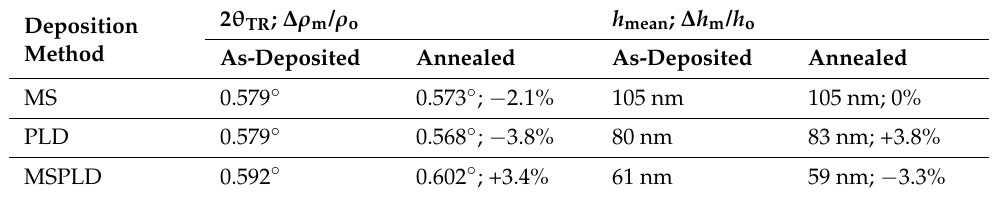
Table 3. Positions of the X-ray’s total reflection edge (2 θ TR ) and the average thickness ( h mean ) of the ZnS thin